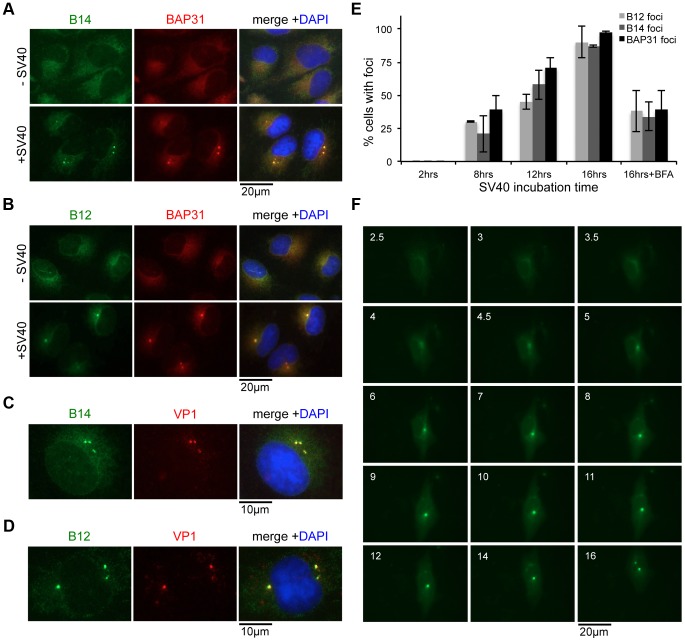
SV40 induces the B14-B12 complex to form foci on the ER membrane.(A) B14 reorganizes into foci upon SV40 infection. CV-1 cells uninfected or infected with SV40 (MOI ≈30–50) for 16 h were fixed and stained with the indicated antibodies for immunofluorescence microscopy. (B) B12 reorganizes into foci upon SV40 infection. As in (A) except B12 antibodies were used. (C) VP1 is present in B14-B12 foci. As in (A) using B14 and VP1 antibodies. (D) As in (C) except using B12 antibodies. (E) Time course experiment monitoring foci formation. Cells were infected as in (A). Where indicated, BFA was added during entry. Cells were fixed at different time points after infection and stained with antibodies against BAP31, B14, or B12. Cells were scored positive if at least one focus was present in the cell. Values represent mean ± SD of three independent experiments. (F) Live cell imaging of GFP-B14 foci formation. Cells were transfected to express B14 with an N-terminal GFP tag. Cells were infected with SV40 and live cell imaging performed beginning at 2.5 h.p.i. Numbers in each frame indicate time in h.p.i.